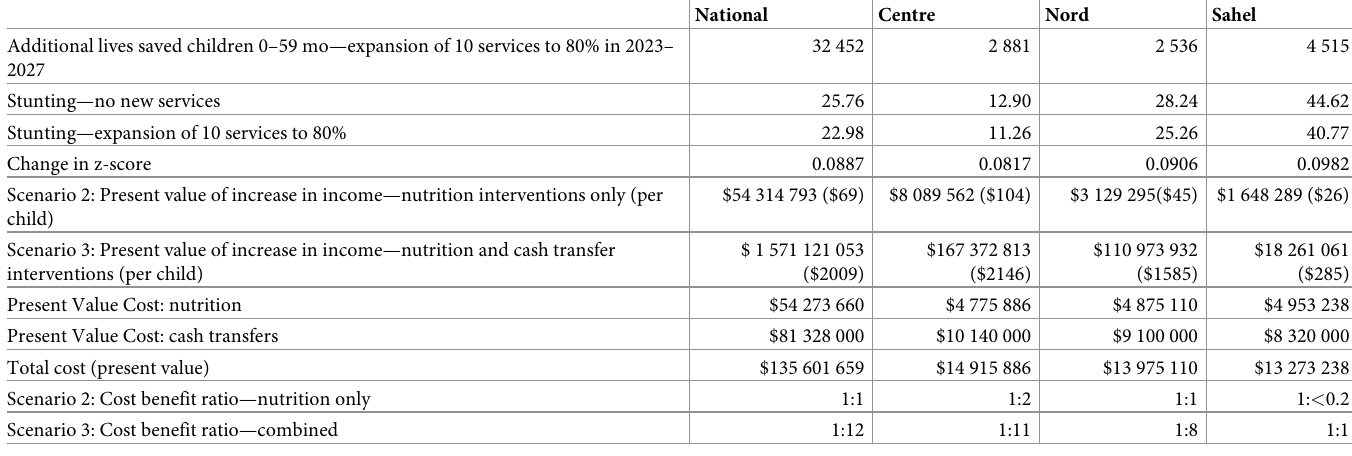
Table 3. Impact, productivity returns and costs of implementing nutrition interventions alone and in combination with cash transfers.